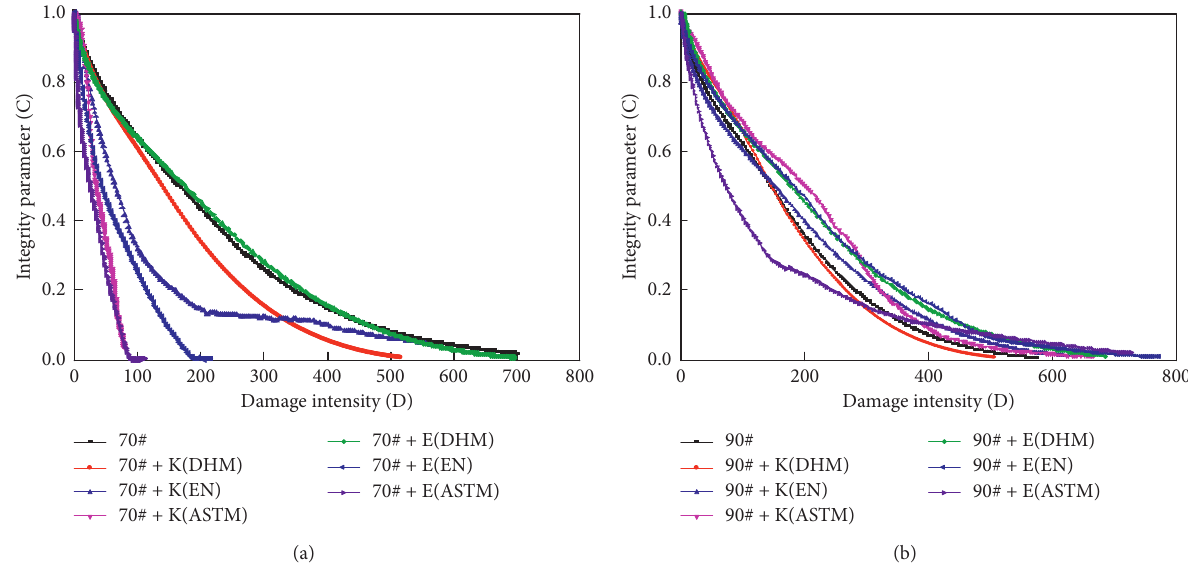
Figure 10: Integrity parameter versus damage intensity for the emulsified asphalt residues.